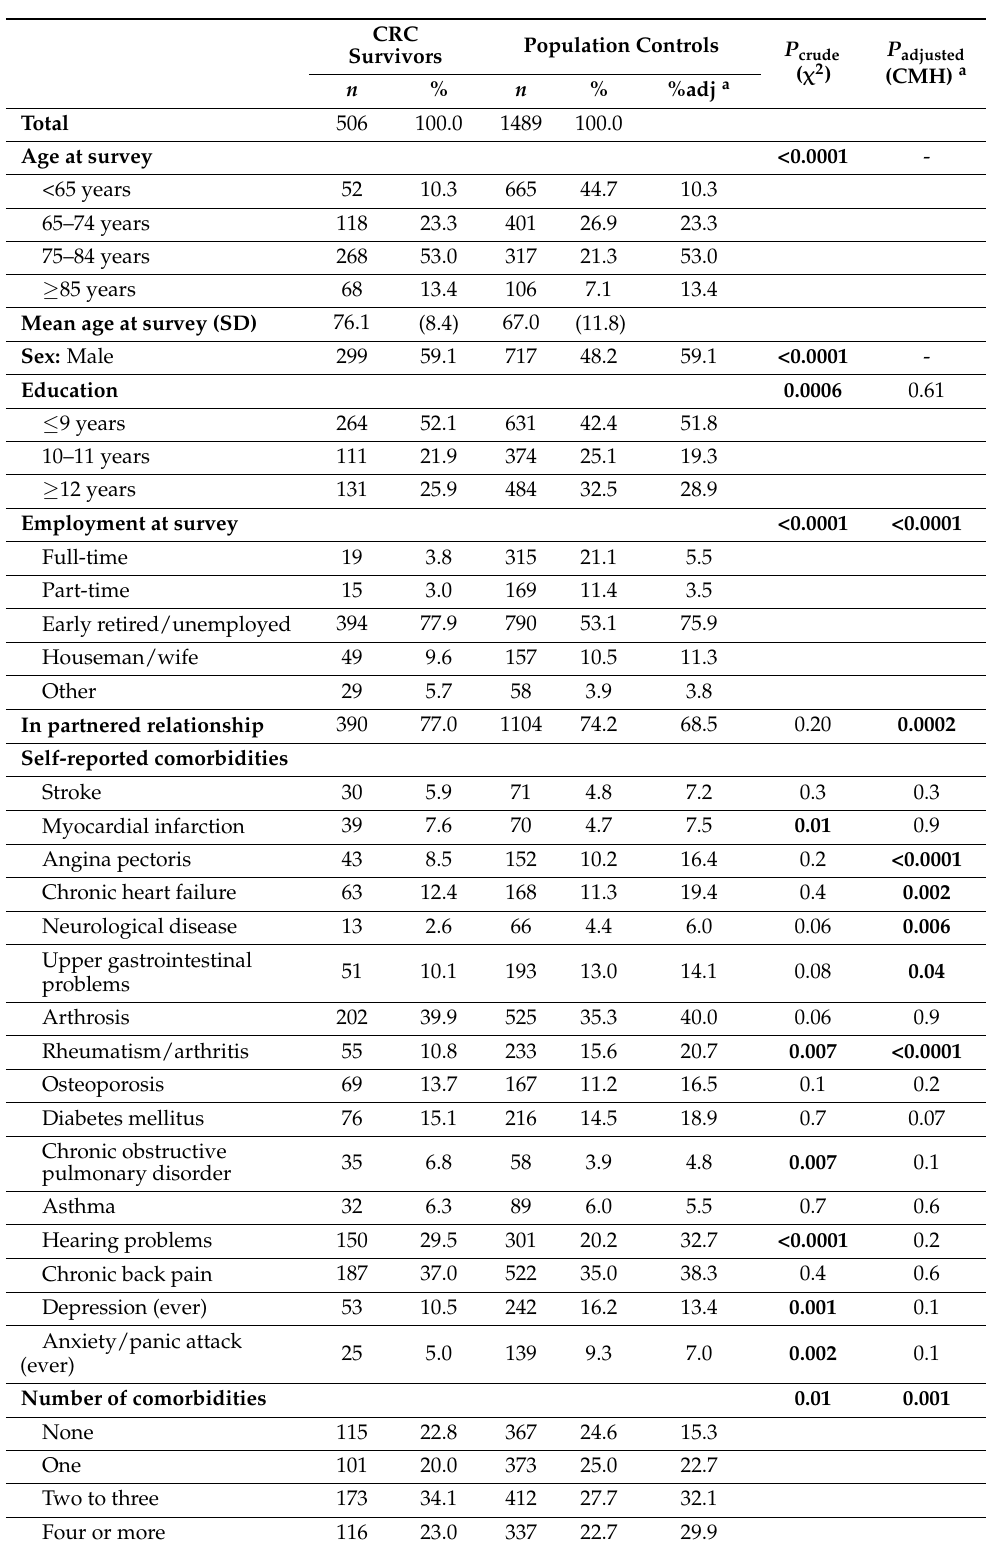
Table 2. Characteristics of CRC survivors and population